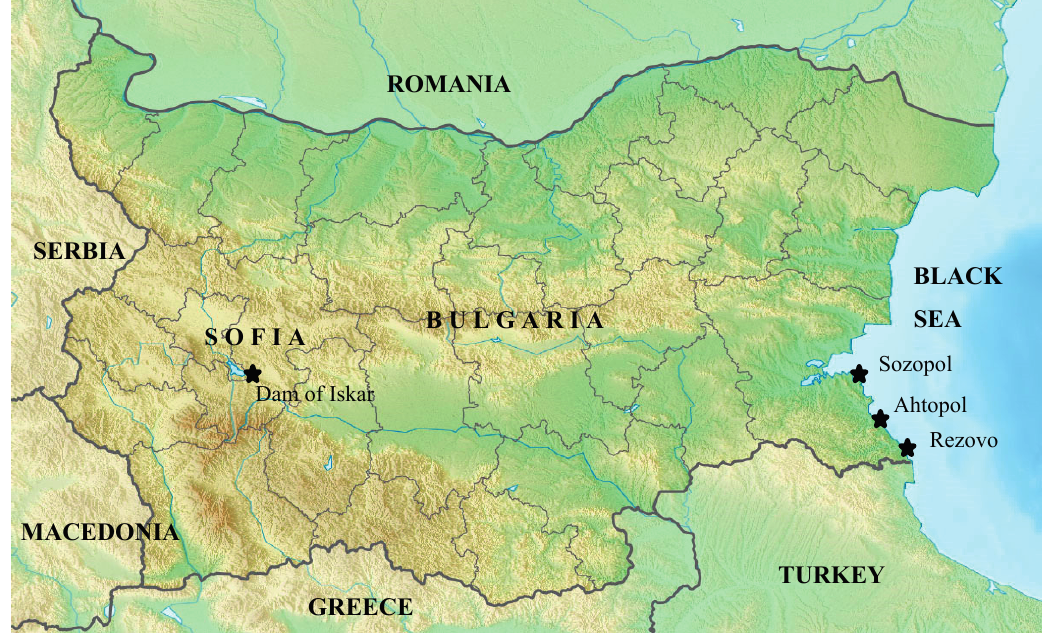
Figure 1. Map of Bugaria, Black Sea and the sampling sites. Sampling sites are highlighted with a